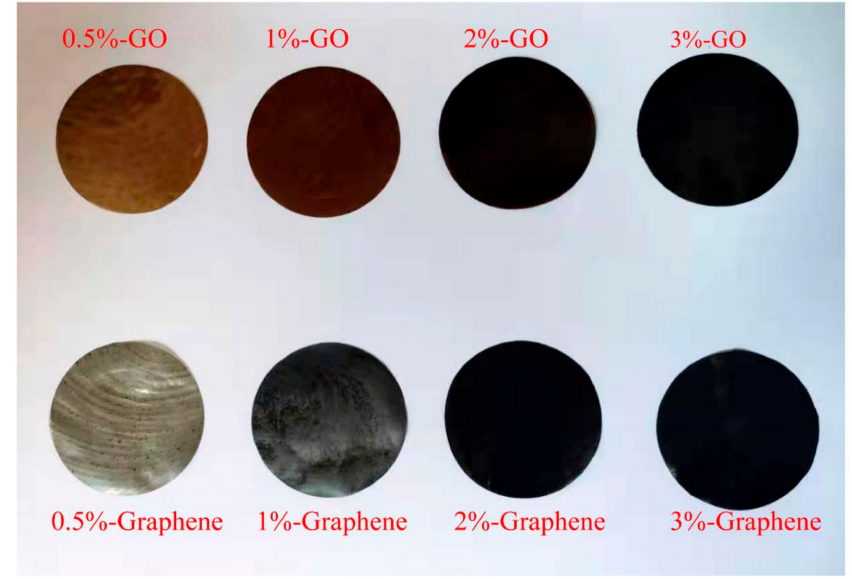
Figure 1. Photos of nano-blend